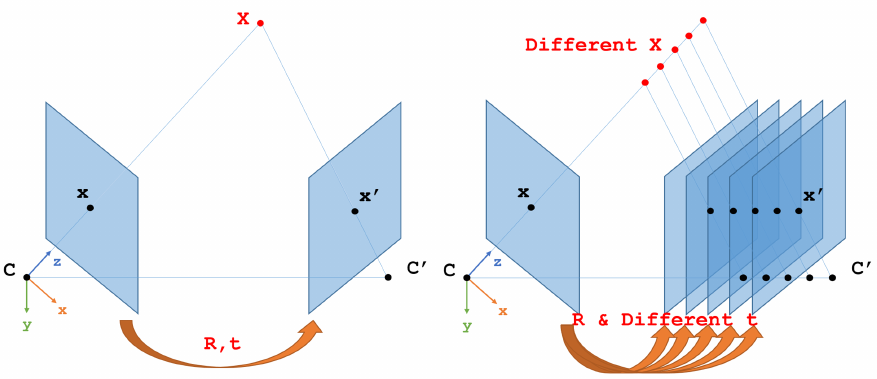
Figure 3. Illustration of 3D point projections on 2D images. C and C (cid:48) are camera centers at different times with a rotation and translation R , t between them. X is a 3D point. X , R and t are unknown in monocular VINS. In the left image RGBD is used and the depth of the pixels is used to get X and PNP [67–69] is used to get R , t with constant scale factor. The right image illustrates the unknown scale factor when using just RGB. By having at least 5 point pairs like x and x (cid:48) , five-point algorithm [66] can be applied to get